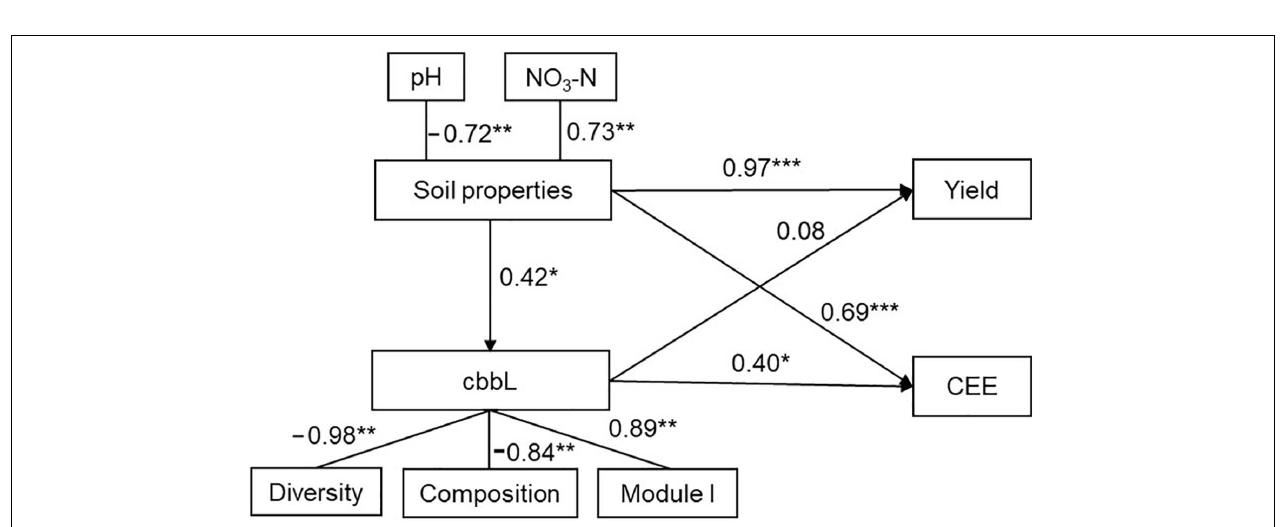
FIGURE 5 | Impacts of soil properties and soil autotrophic bacterial community on crop yield and carbon emission efficiency (CEE) as estimated using structural equation modeling (SEM) analysis. Based on random forest analyses, the significant predictors were chosen to perform the SEM analysis. The latent variables inside the ellipse were used to integrate the effects of multiple conceptually related observed variables into a single-composite effect. Soil properties are represented by pH and nitrate nitrogen (NO 3 –N). Soil autotrophic bacterial community ( cbbL ) is represented by the diversity (Shannon index), composition [first principal coordinates (PCoA1)], and two modules (module II and module III) of the soil cbbL -carrying bacteria. * P < 0.05; ** P < 0.01; *** P < 0.001.